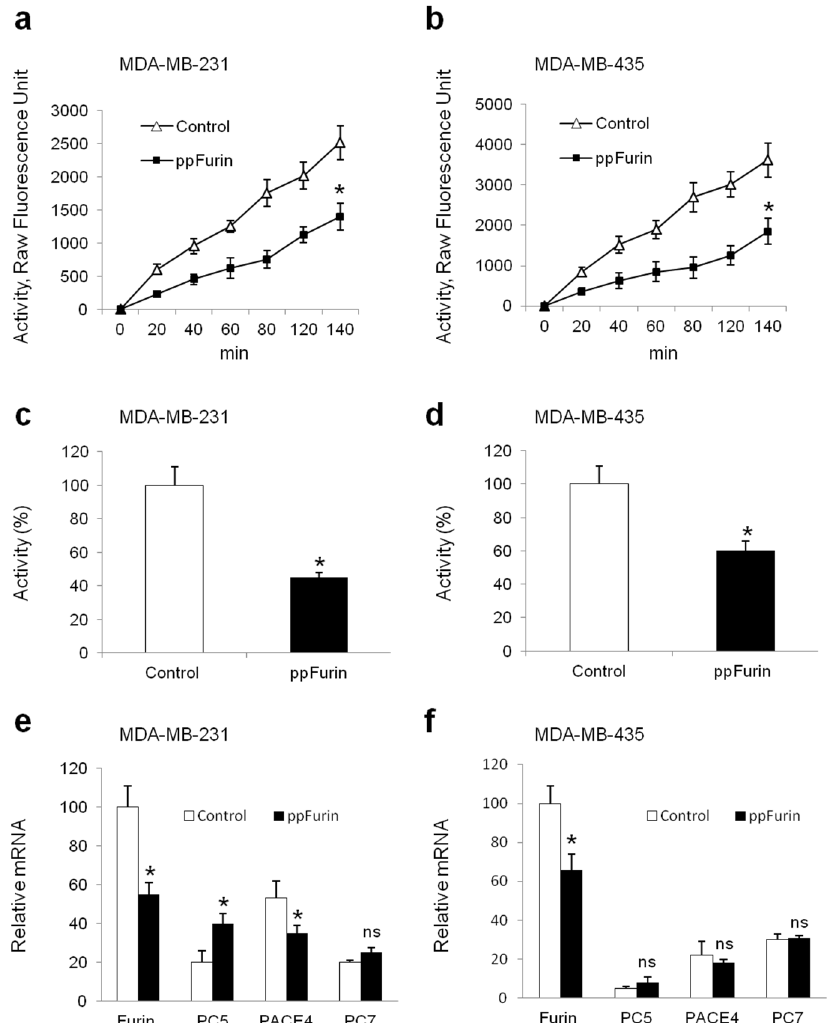
Figure 1. Inhibition of Furin activity by ppFurin in breast MDA-MB-231 and melanoma MDA-MB-435 cell lines. ( a , b ) MDA-MB-231 and MDA-MB-435 cells were stably transfected with pIRES2-EGFP empty vector (control) or pIRES2-EGFP-ppFurin and the proprotein convertase (PC) activity was evaluated by the measurement of cell lysates’ ability to digest the universal PC substrate pERTKR-MCA at the indicated time periods. ( c , d ) Bar graphs representing PCs activity of MDA-MB-231 and MDA-MB-435 cells at 2 h of incubation in the absence and presence of ppFurin. ( e , f ) Real-time PCR analysis of indicated PC expression in control and ppFurin-expressing cells. Results are shown in the bar graphs and are expressed as the percentage of enzymatic activity or transcripts relative to controls (100%). All values are presented as means ± SEM of three independent experiments. Statistical significance was assessed by t -test and * represents p < 0.05 as compared to the corresponding controls.